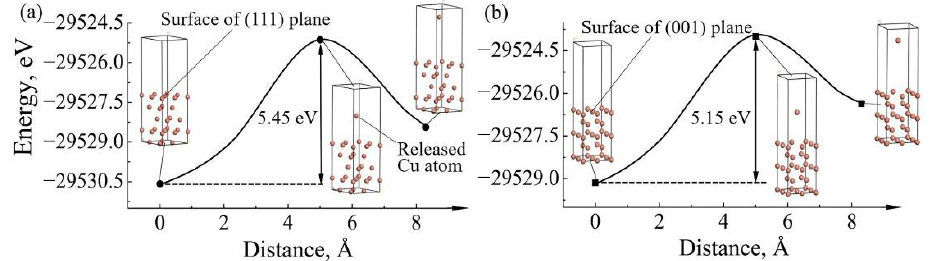
Figure 4. Total energy of releasing Cu atom versus the distance between the released Cu atom and the surface of a crystal plane, estimated in slab models of ( a ) the (111) plane and ( b ) the (001) plane.